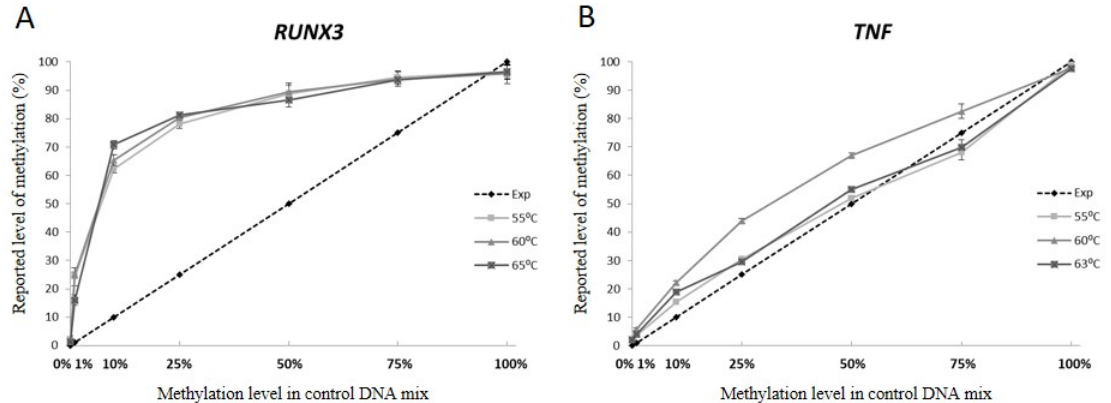
Figure 2. The influence of varying annealing temperatures on the quantitative methylation assess- ment by pyrosequencing of ( A ) RUNX3 and ( B ) TNF genes sequences. The dashed line depicts expected methylation level assuming equal amplification of methylated and non-methylated versions of the template. Lines in shades of grey describe the methylation level reported by pyrosequencing data at three different annealing temperatures for each of the control mixes. The reported methylation level for each of the control mixes is an average level of methylation over the analysed CpG sites sequenced in the given amplicon.